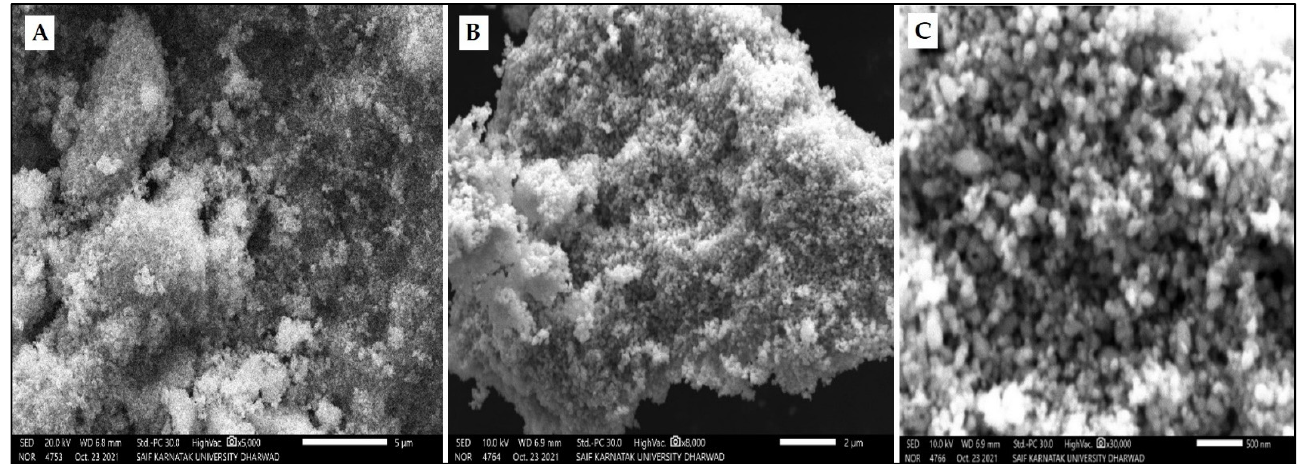
Figure 6. SEM images of ZnONPs at magnifications of ( A ) 5000 × , ( B ) 8000×, ( C ) 30000×.